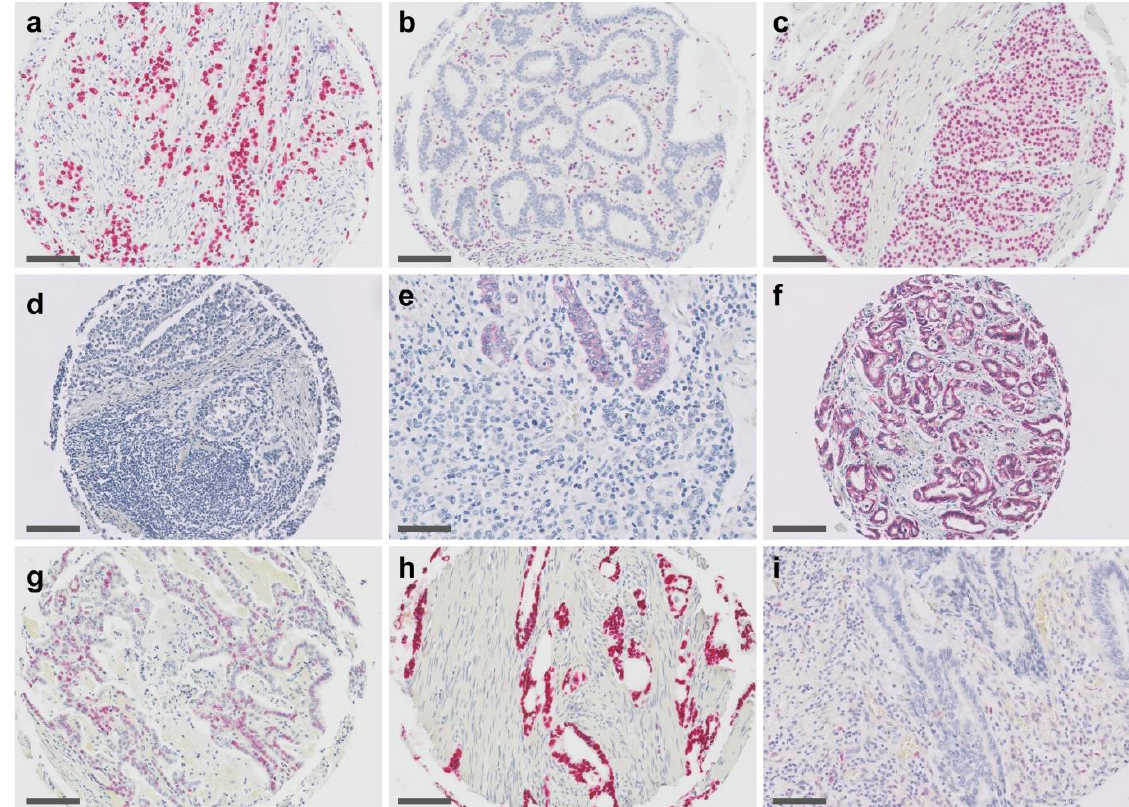
Figure 1. In situ hybridization and immunohistochemistry for gastric adenocarcinoma. ( a ) Epstein – Barr virus (EBV)-encoded RNA (EBER) detected by in situ hybridization in EBV-associated GAC. ( b ) Immunohistochemistry of MLH1 in a microsatellite instable tumor (MSI) presenting with a complete loss of staining in the nuclei of tumor cells and retained expression in adjacent stromal cells. ( c ) Retained MLH1 expression in tumor and stromal and inflammatory cells of a microsatellite stable cancer (MSS). ( d – f ) Expression of E-Cadherin: ( d ) Homogenous complete loss for E-Cadherin (note: lymphocytes in lower half of image are endogenously negative for E-Cadherin). ( e ) Heterogeneous expression: areas with glandular differentiation show a weak E-Cadherin expression, whereas the undifferentiated region (lower half of image) shows complete loss. ( f) Tumor with strong E-Cadherin expression. ( g – i ) Expression of p53 in GAC detected by immunohistochemistry: ( g ) Wild type expression showing a mixture of negative cells, weakly as well as strong positive cells. Aberrant expression include ( h ) overexpression with a strong diffuse positivity in ≥ 80% of tumor cell nuclei and ( i ) complete loss of staining in all tumor cell nuclei with a variable, usually weak positivity in the surrounding stromal cells. Scale bars indicate 100 µm.